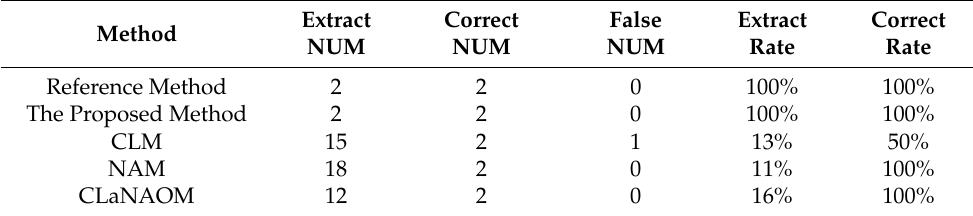
Table 16. The mountain vertices extraction results for each method using the fifth dataset.